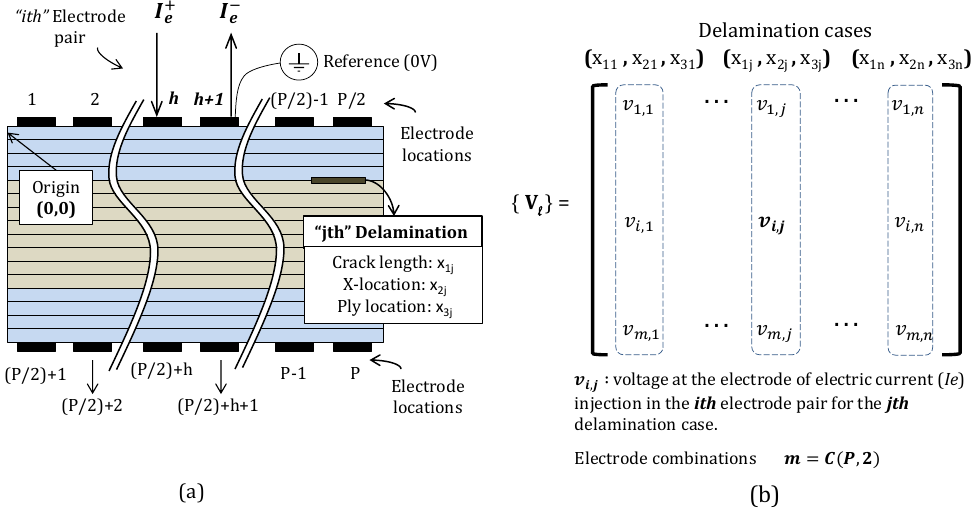
Figure 3. Formulations for the resistance measurements. ( a ) Schematic representation of the 2D model for the composite laminate (case of [ 0 4 /90 4 ] s ); ( b ) Electric potential matrix for a composite under damage